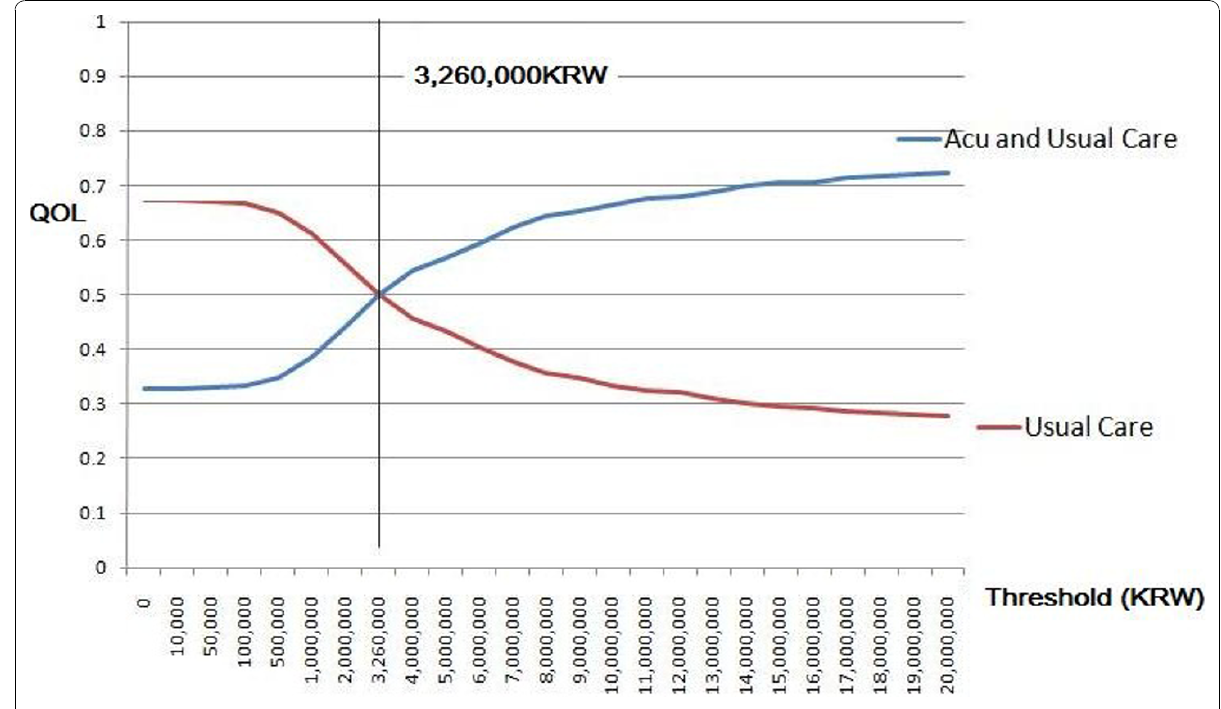
Figure 5 CEAC for chronic low back pain (probabilistic sensitivity analysis)